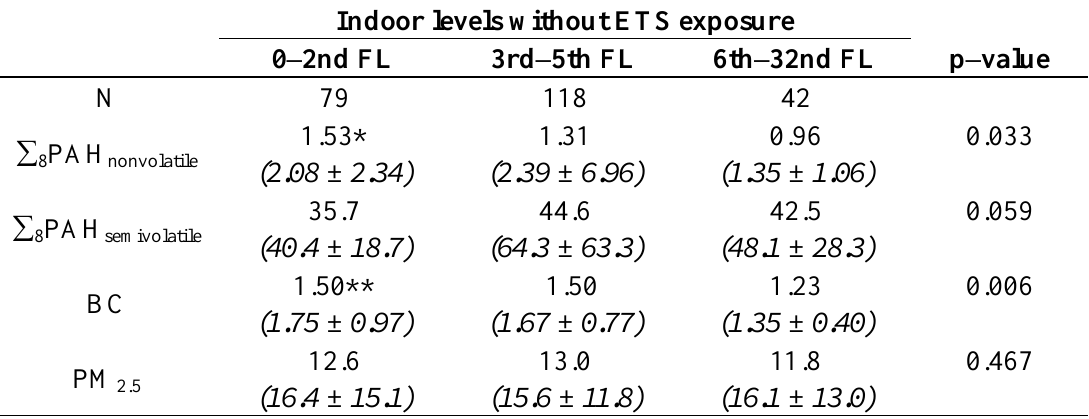
Table 2. Indoor levels of air pollutants by FL among homes without ETS